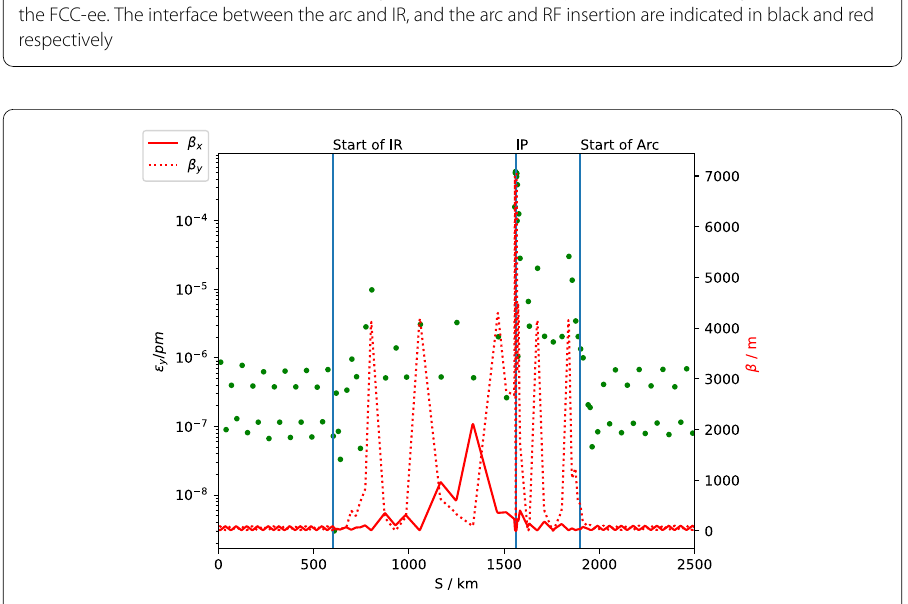
Figure 5 Absolute value of vertical emittance from analytical expression for 10 μ rad roll errors on single quadrupoles in the FCC-ee insertion region, plotted together with the β functions in this